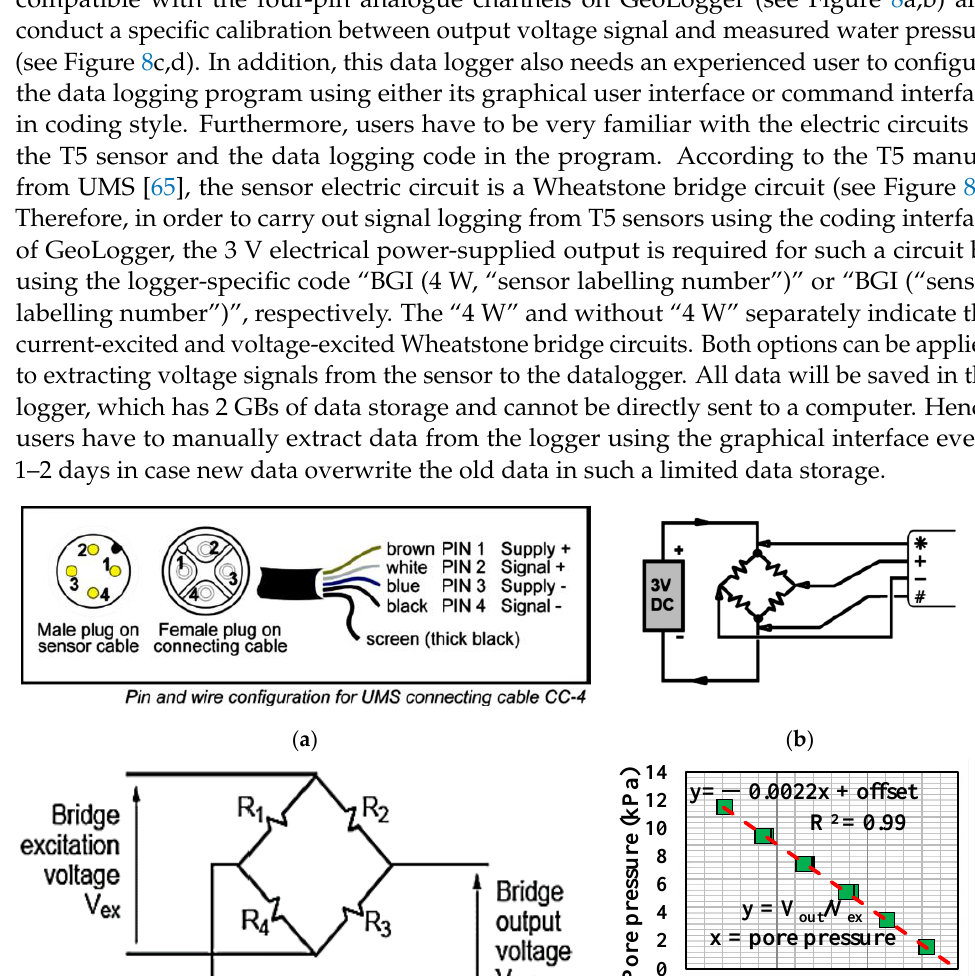
11 of 32 ( c ) Figure 7. Three data logging systems for T5 tensiometers: ( a ) the Infield 7 hand reader provided by UMS [65]; ( b ) the 6-channel DL6-te and dual-channel GP1-te data loggers provided by UMS [65]; ( c ) the 18-channel DT85g Series 3 DataTaker GeoLogger linked with the 20-channel CEM20 channel expansion board, allowing a maximum number of 37 analogue channels connected to sensors [68]. This series of soil column tests required a total of 24 channels for four soil columns (6 channels to 6 T5 sensors for each soil column). Due to a shortage of enough channels in the 6-channel DL6-te data loggers and a cost-effective trade-off between buying four such log- gers and seeking a more cost-effective logging solution, the custom-made loggers were re- placed by a non-custom-made one, the 18-channel DT85G Series 3 DataTaker GeoLogger